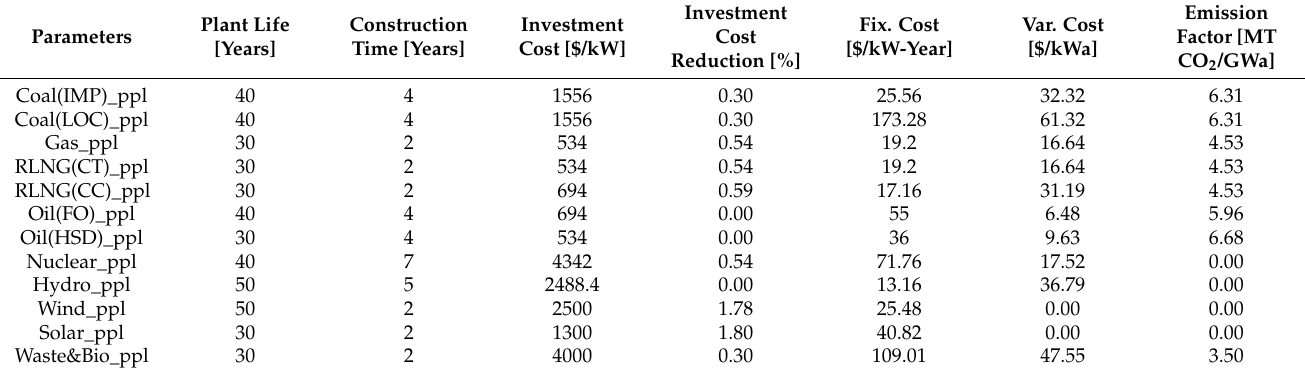
Table 13. Cost and environmental parameters of power technologies